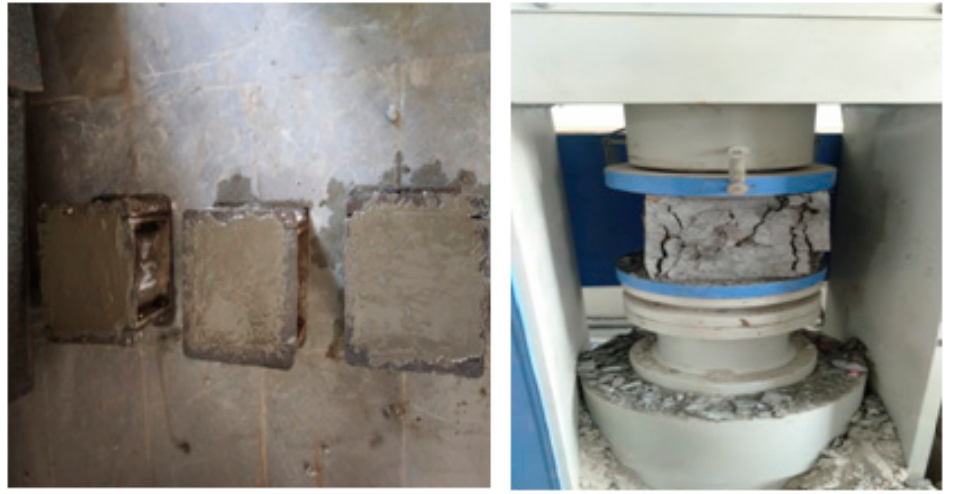
Figure 2. Casting and testing of CS concrete specimen.